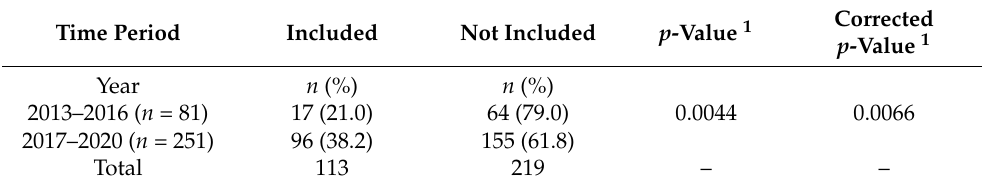
Table 2. Number of news reports that included ethics-related